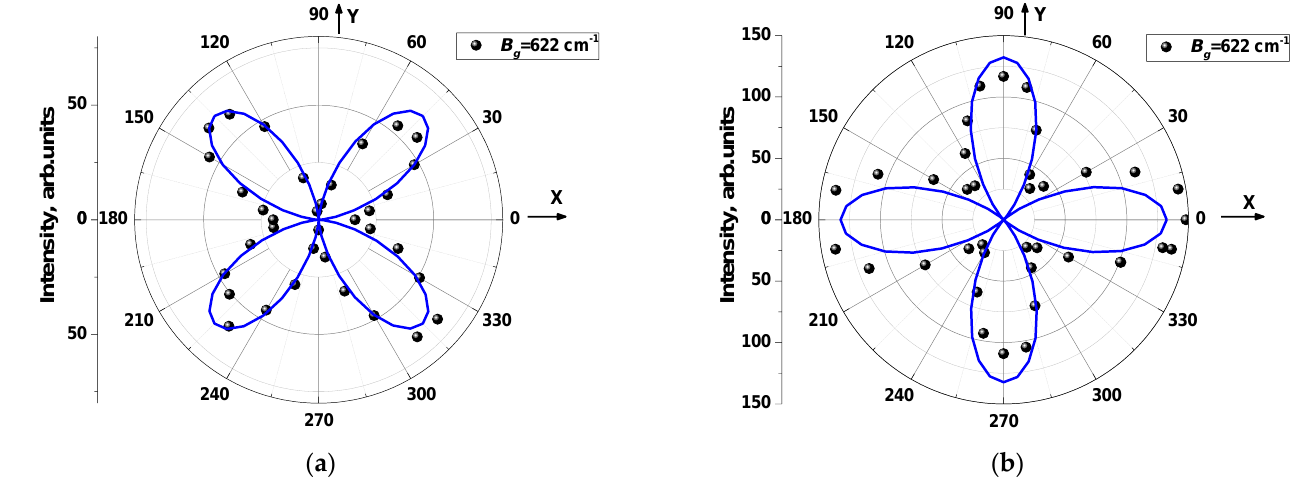
Figure 7. Angle variations of Raman intensity measured in PP ( a ) and CP ( b ) geometry for line ν = 622 cm − 1 of B g symmetry.